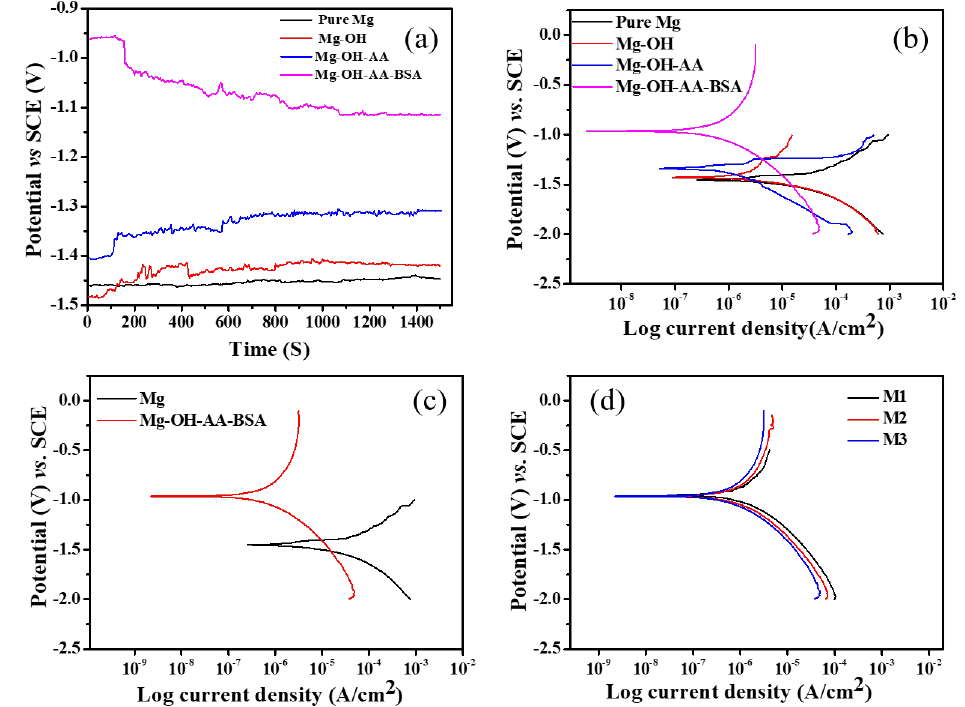
Figure 7. Electrochemical corrosion study. ( a ) OCP vs. time; ( b ) potentiodynamic polarization curves; ( c ) potentiodynamic polarization curves of Mg and Mg-OH-AA-BSA only; and ( d ) polarization curves obtained from Mg-OH-AA-BSA (n = 3). All samples were treated in SBF solution at 37 °C for 1 h 30 min, before analytical measurements.